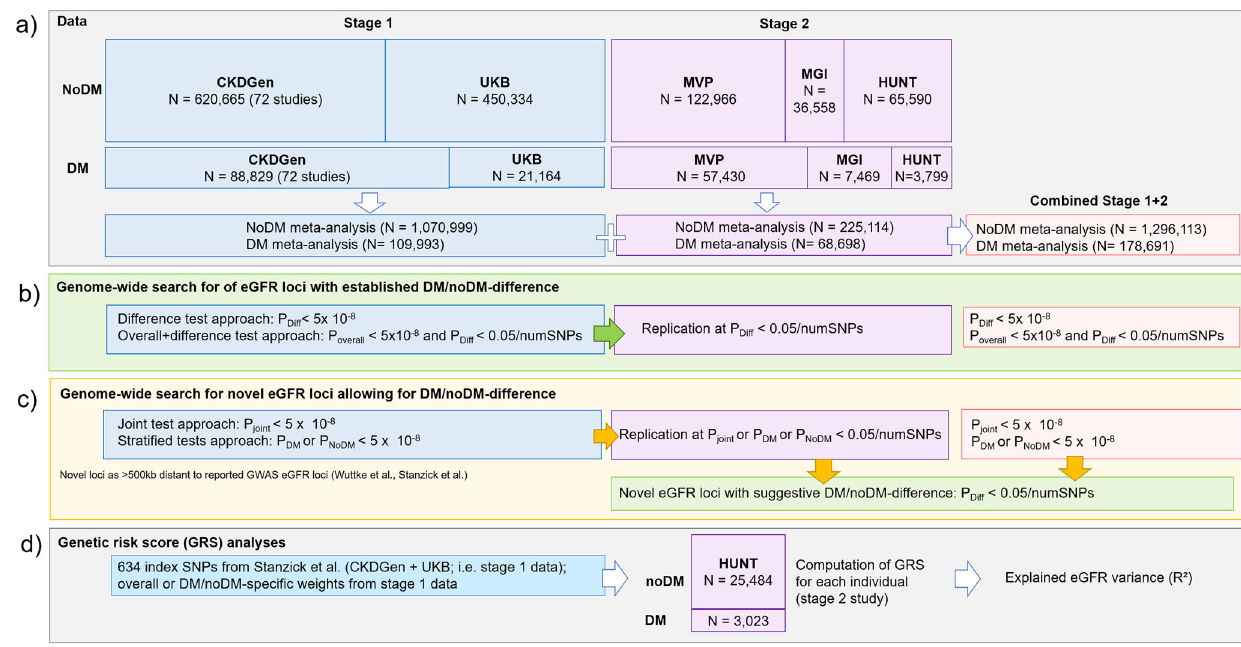
Fig. 1 Data and analysis work fl ow. a Overview on datasets and meta-analyses. b Approaches to identify DM/noDM-differences. c Approaches to identify novel eGFR loci and suggestive DM/noDM-differences. d Genetic risk score (GRS) analyses in